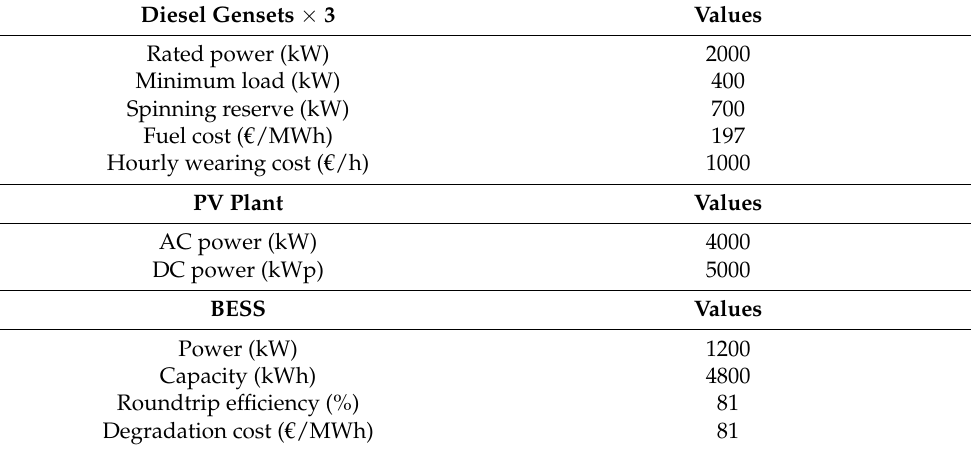
Table 1. Elements of the hybrid microgrid